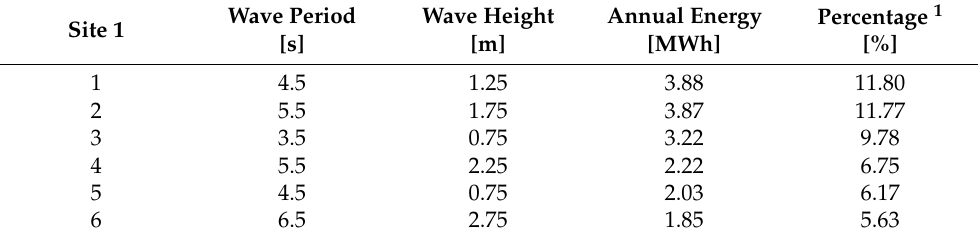
Table 3. Sea states (75 sea states in total) that contributed the most to the total annual energy at Site 1.